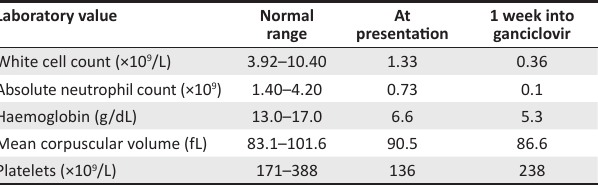
TABLE 1: Full blood count and absolute neutrophil count at presentation and 1 week into ganciclovir therapy.